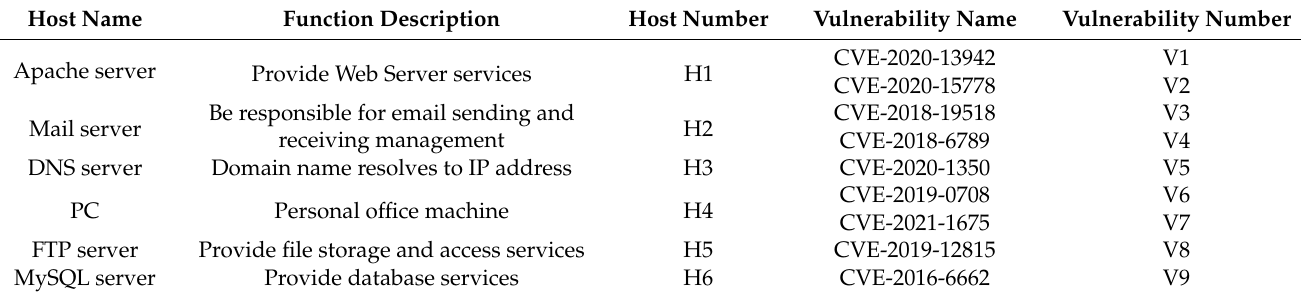
Table 2. Host and Vulnerability Information of Network